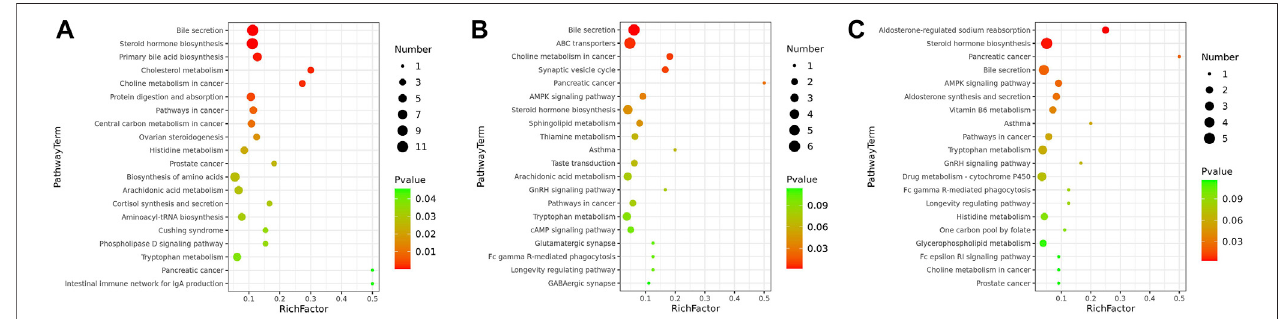
FIGURE 4 | Bubble diagrams of the control, cholestasis model, and ZYP treatment groups. (A) Model vs Control group; (B) ZYP − vs Model; (C) ZYP+ vs Model, respectively. The x-axis shows the Rich factor, the color of each circle indicates the p -value, and the size of each circle re fl ects the number of metabolites of each